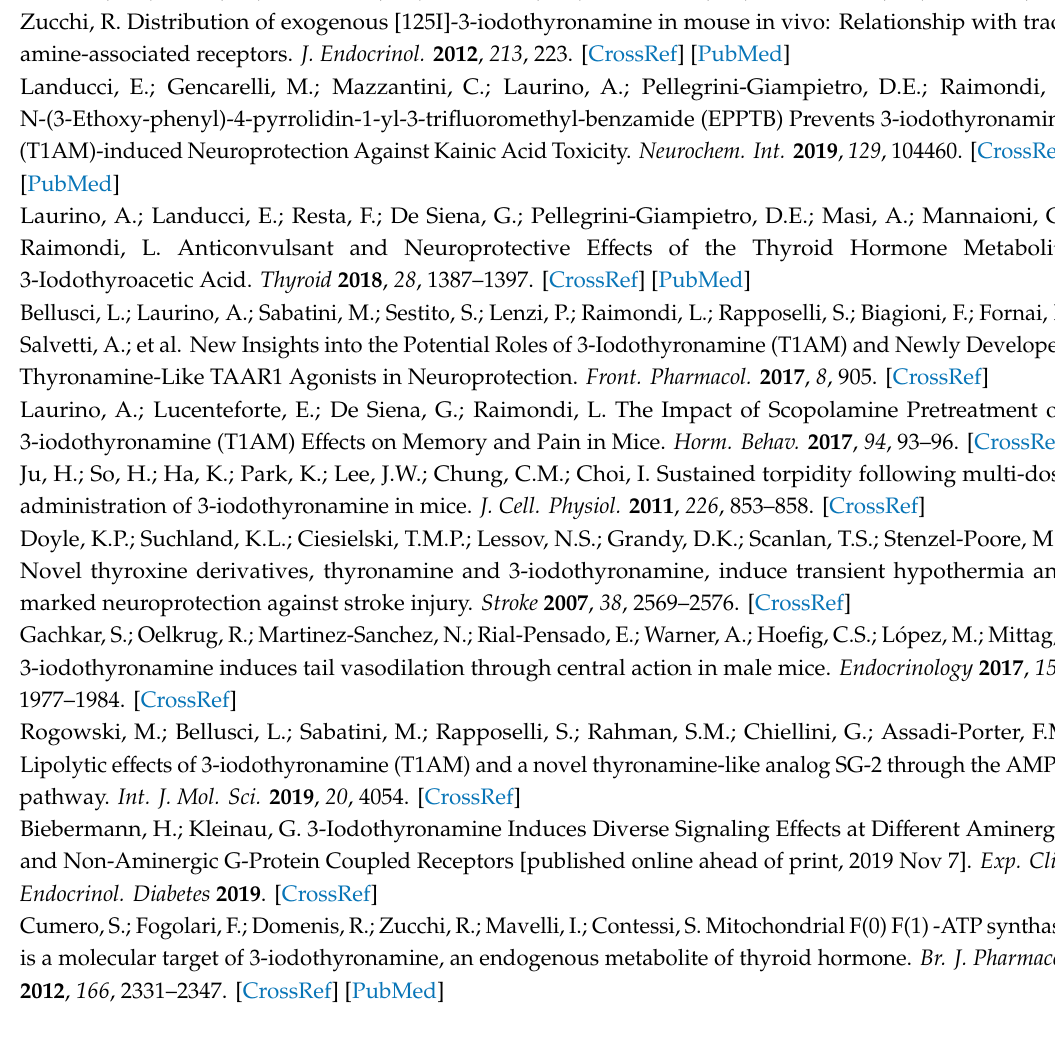
Figure S1: The expression levels of GLUT1 in M and M + T1AM cells, Table S1: Primary and secondary antibodies used for immunofluorescence (IF) and Western-blot analysis